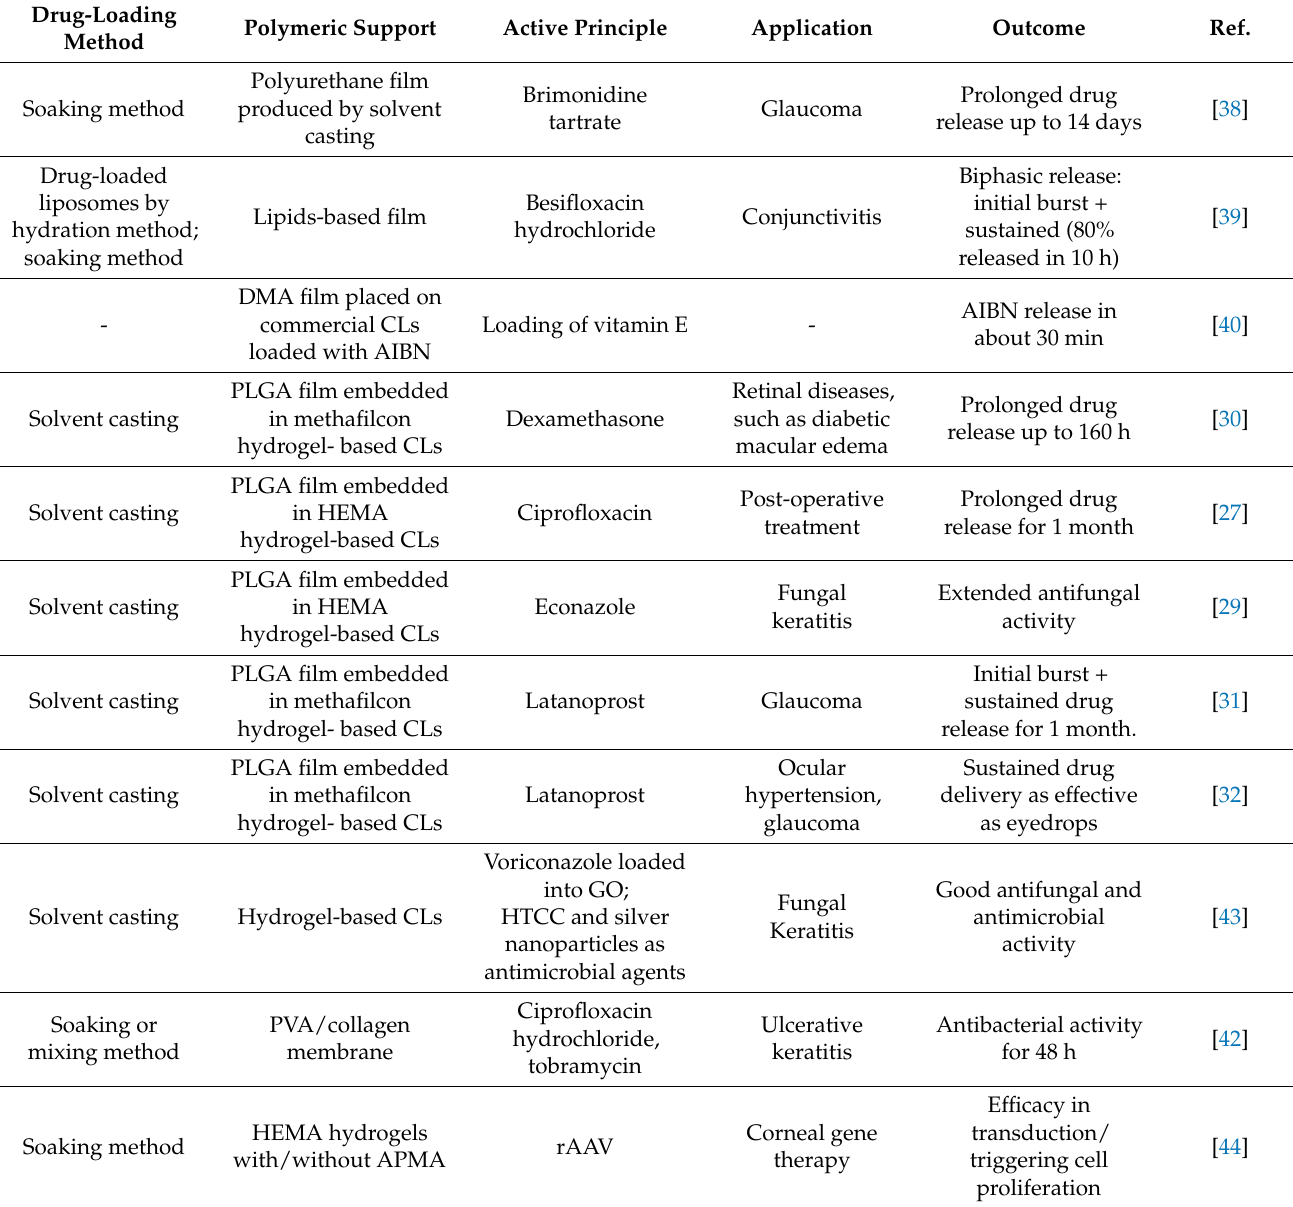
Active Principle Application Outcome